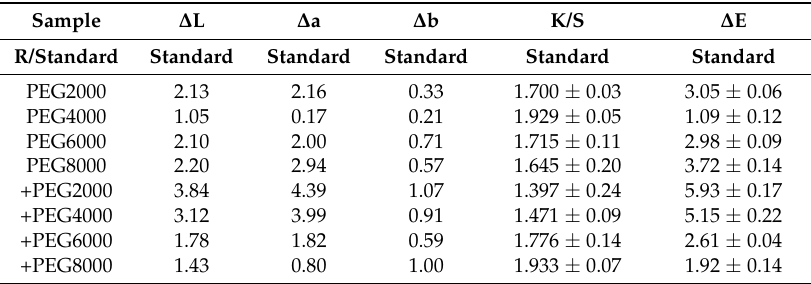
Table 2. Dyeing properties of the dispersed red